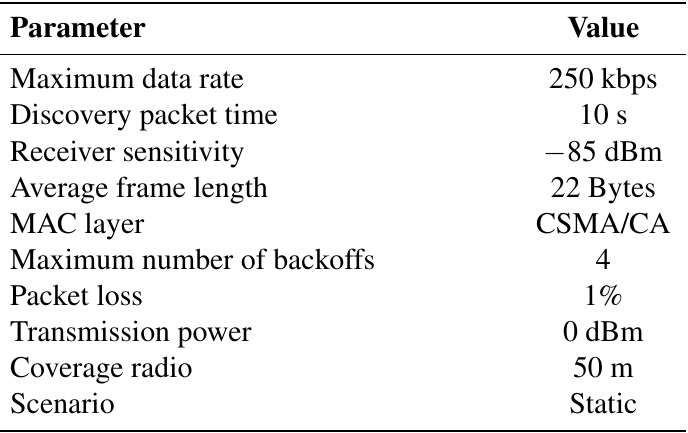
Table 4. Parameters for the tested scenarios.